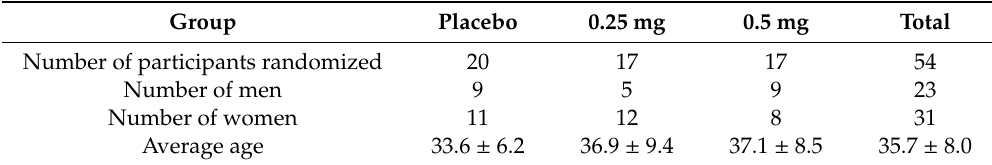
Table 1. Demographic characteristics of trial